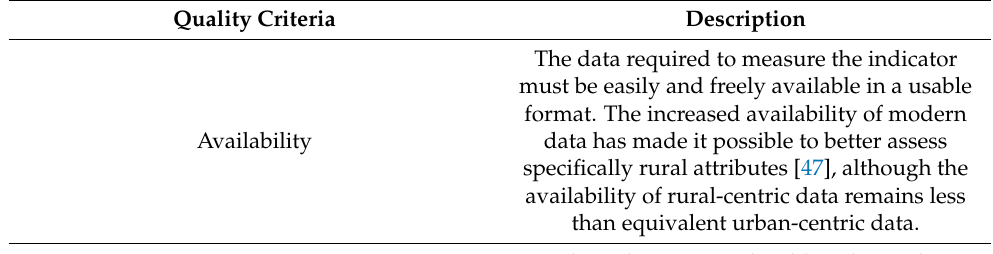
Table 3. CARTI indicator quality